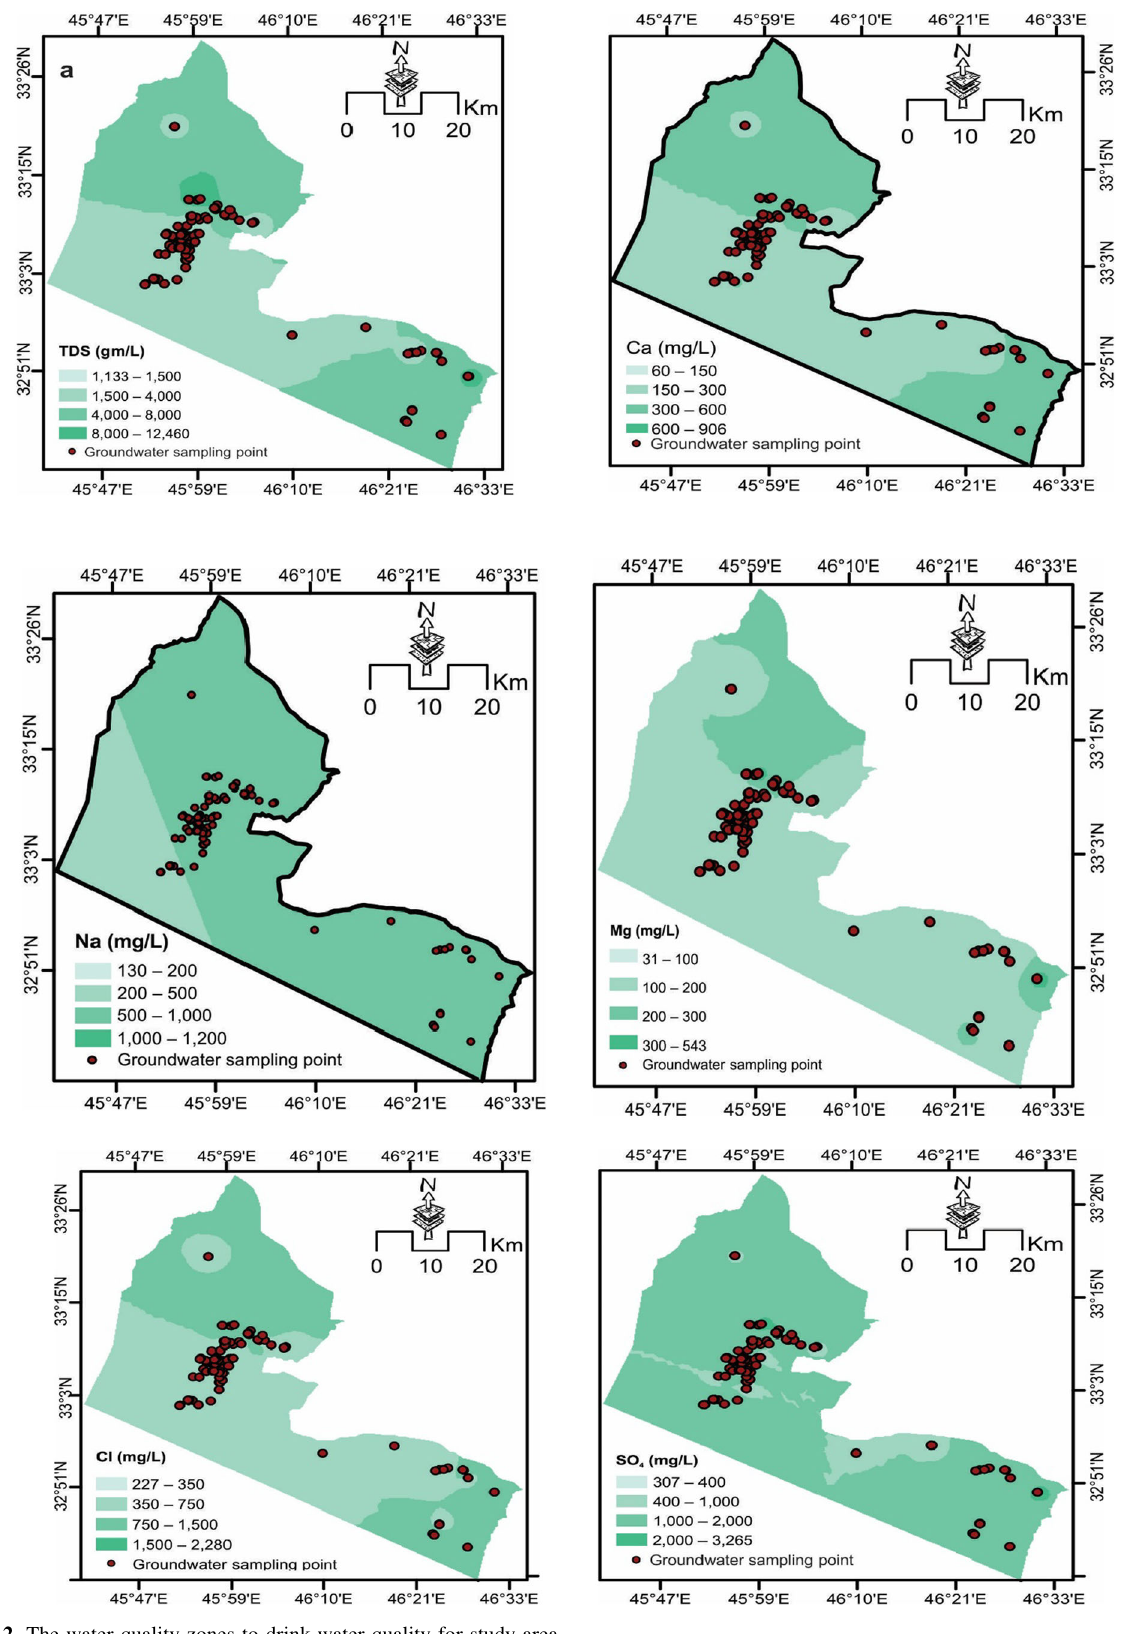
Fig. 12 The water quality zones to drink water quality for study